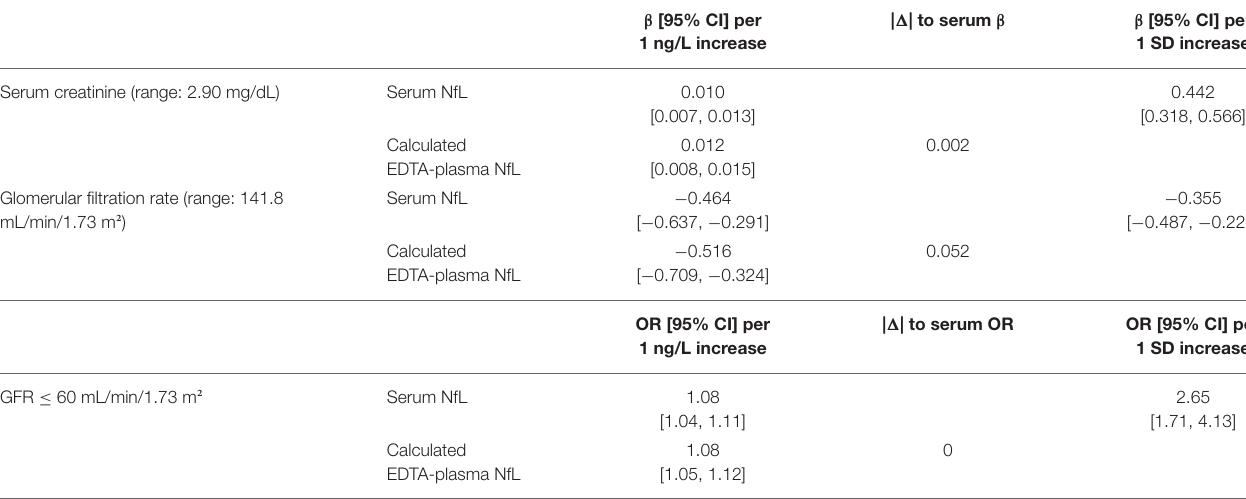
TABLE 3 | Results of regression analyses in